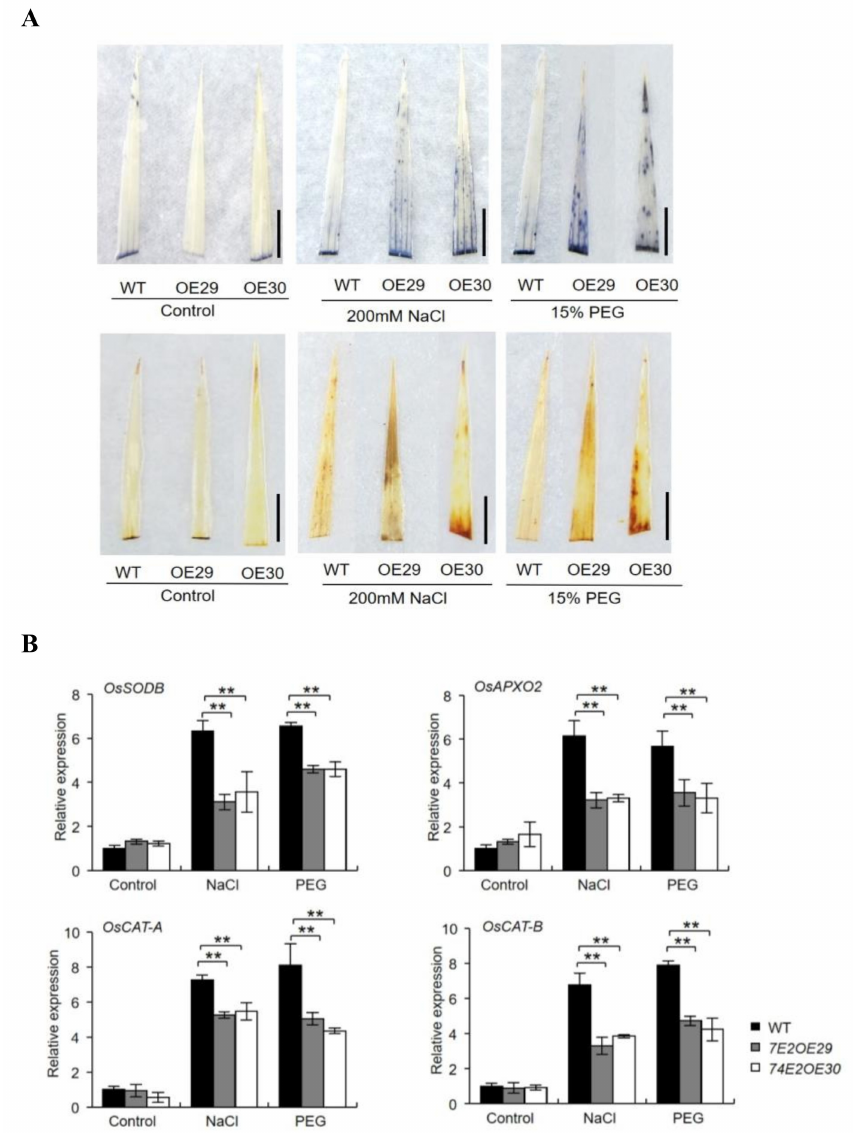
Figure 7. Accumulation of ROS under NaCl and PEG treatments. ( A ) Two-week-old seedlings were subjectedtonitrobluetetrazoliun(NBT)anddiaminobenzidine(DAB)stainingaftertreatmentwithNaCl and polyethylene glycol (PEG) for 24 h. (scale bars = 1 cm) ( B ) Genes encoding antioxidant enzymes are downregulated upon UGT74E2 overexpression under abiotic stress. For RNA extraction, seven-day-old rice plants were subjected to 200 mM NaCl and 15% PEG treatment for 12 h. Gene expression was normalized to the reference gene OsActin . For each experiment, three replicates were done; data are presented as means ± SD. Student’s t -test for each genotype was performed (** p <